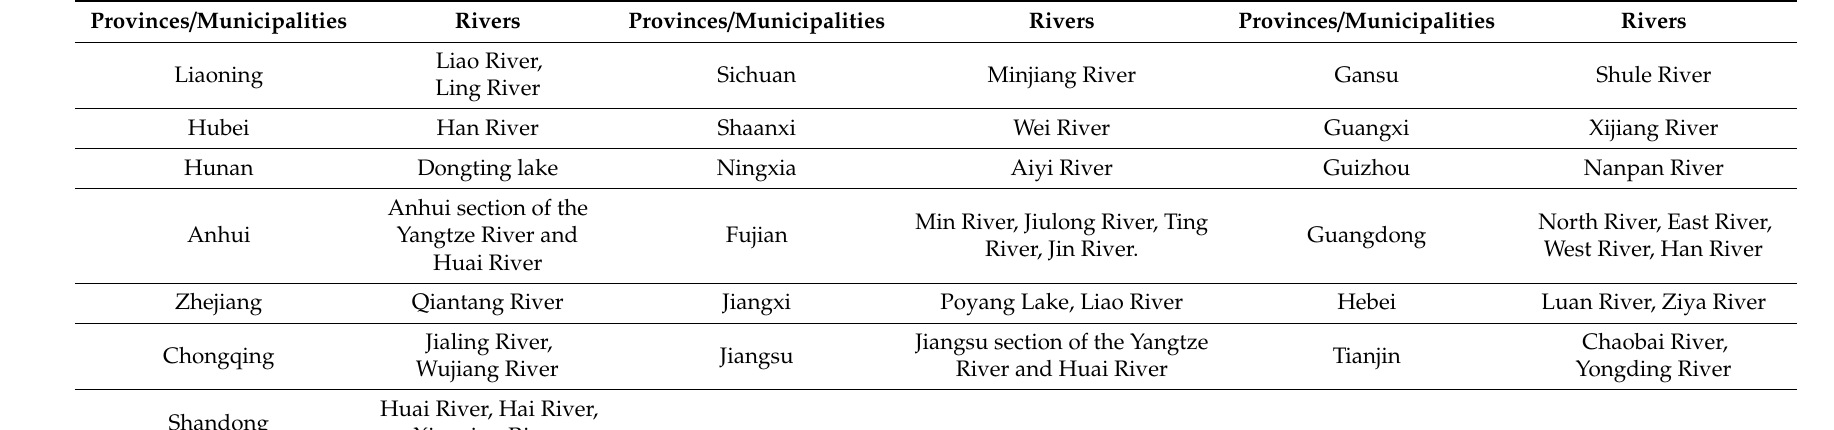
Table A1. The main rivers of the 19 provinces and municipalities.